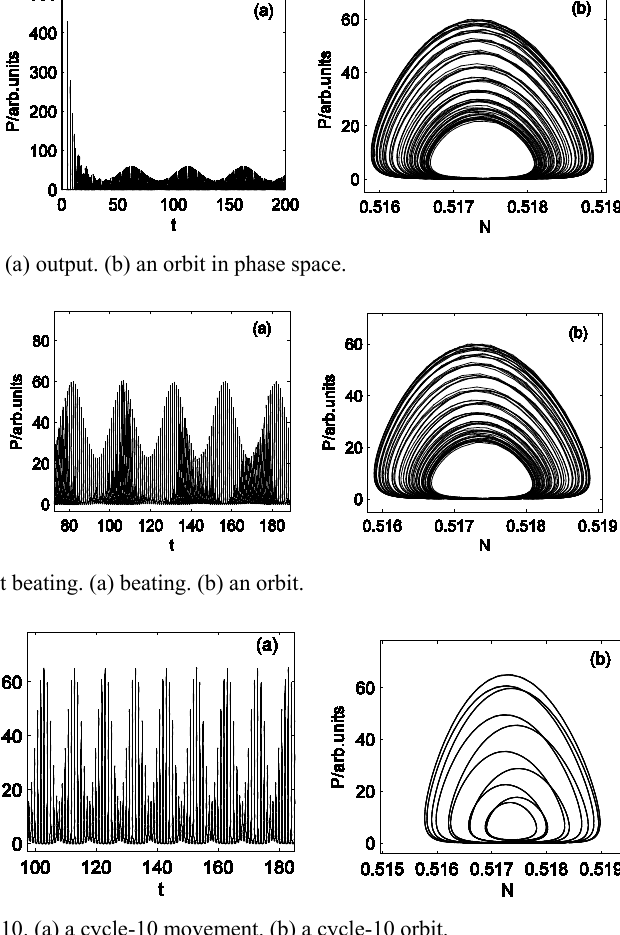
Fig. 3. A cycle-10. (a) a cycle-10 movement. (b) a cycle-10 orbit.